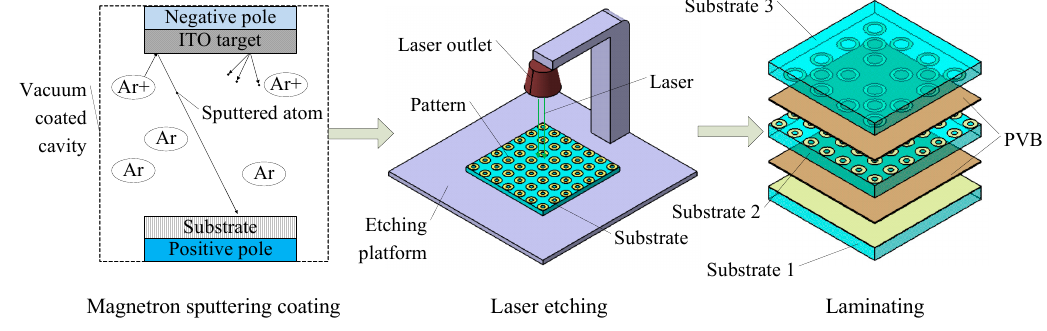
Figure 9. The production flow chart of the sample.